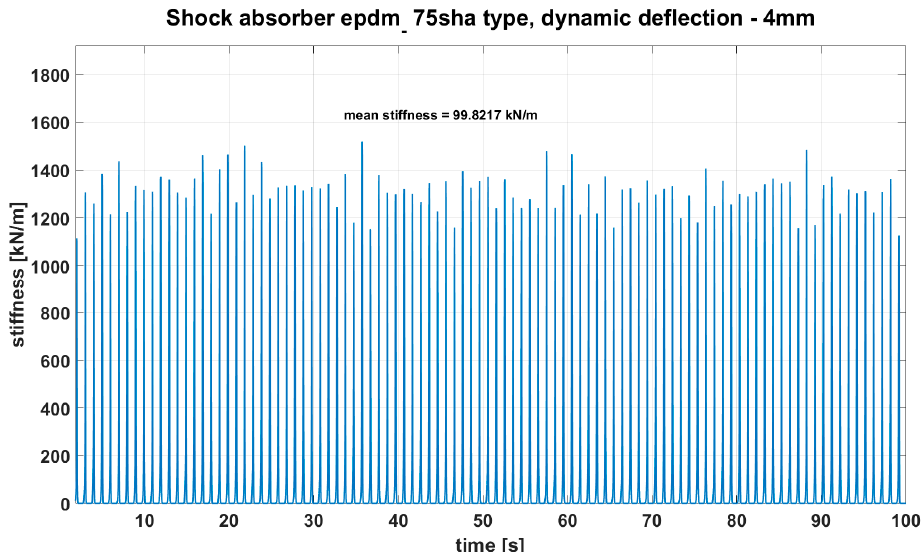
Figure 7. Result of dynamic measurements of shock absorber’s stiffness made with velocity 5 m/s and probe frequency 0.9 Hz, material 75 Sh A EPDM.